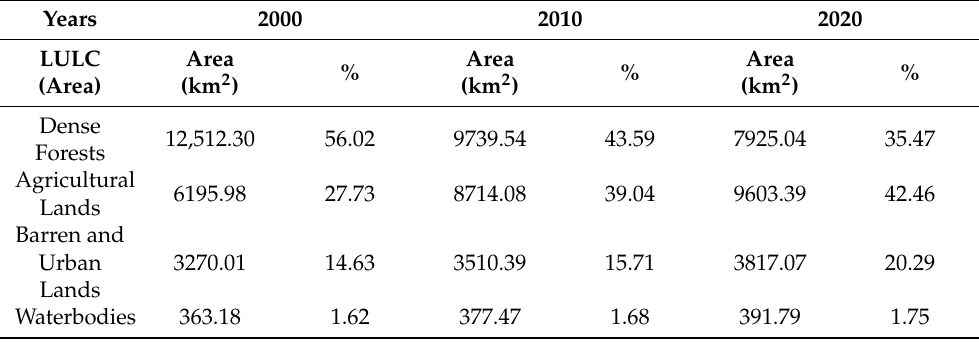
Table 4. Outcomes of the classification of LULC for images from the years 2000, 2010, and 2020, demon-strating the area of each class and its percentage of the Perak River basin.